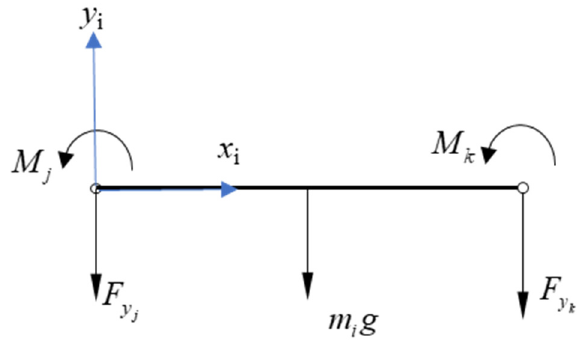
Figure 5. Equivalent diagram of uniform load.